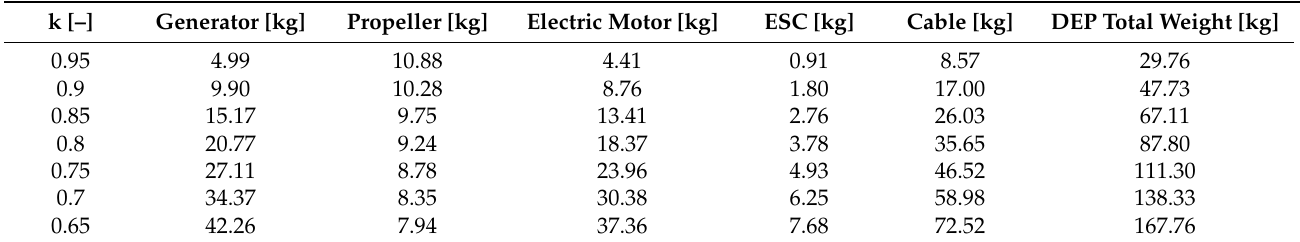
Table 3. Results of DEP sizing for twenty propellers, mass quantities.